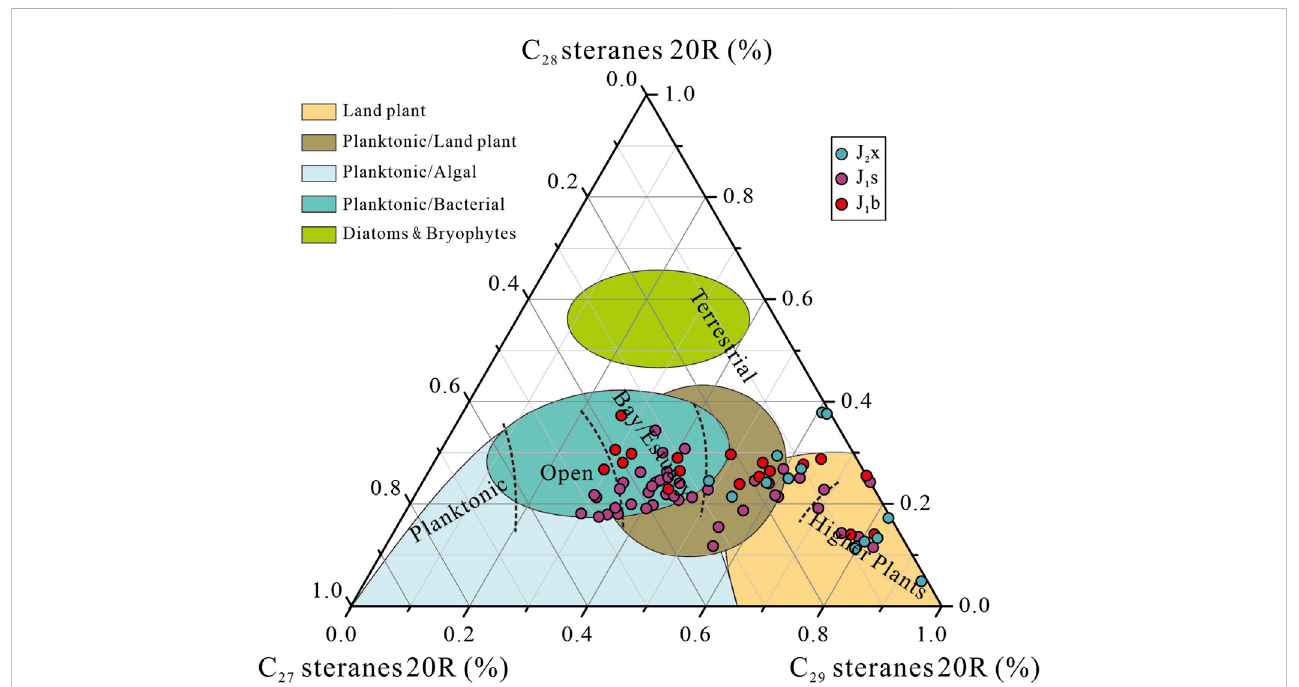
FIGURE 6 Ternary diagram showing the distribution of C 27 , C 28 and C 29 steranes and the Jurassic organic-rich shales ’ depositional environment in the East Fukang Sag, Junggar Basin, China (modi fi ed after Huang and Meinschein, 1979; Moldowan et al., 1985).